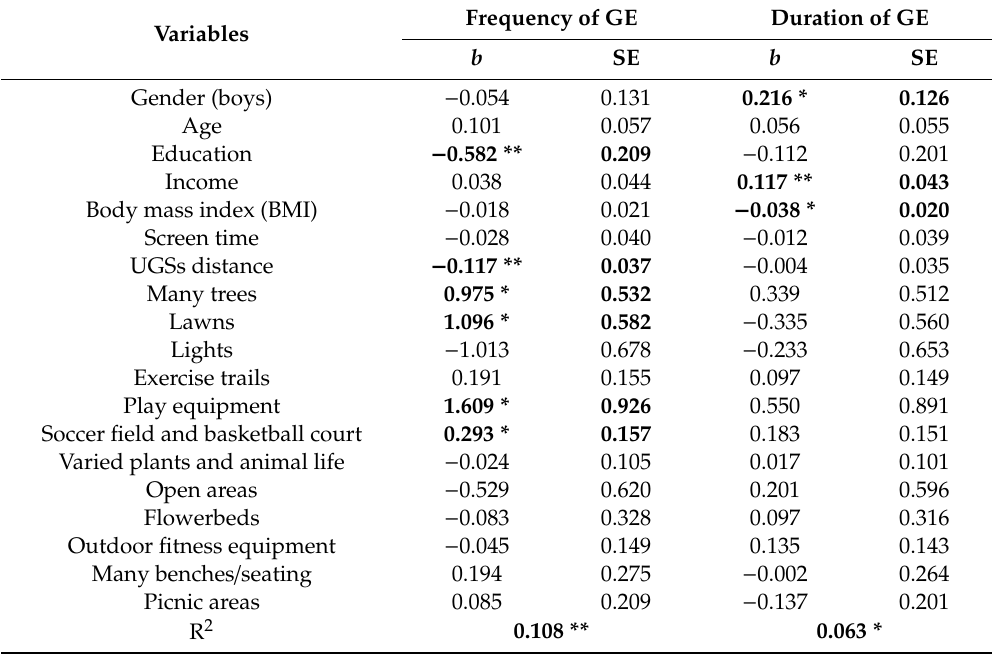
Table 2. Associations between characteristics of urban green spaces (UGSs) and adolescents’ frequency and duration of